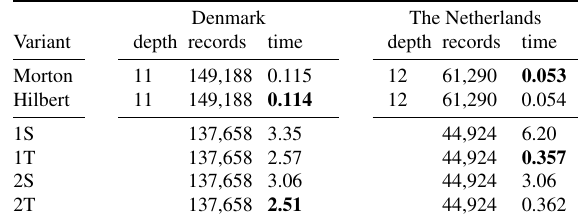
Table 2. Size comparison (in GB), comparing the SFC approach against the regular indexed tables